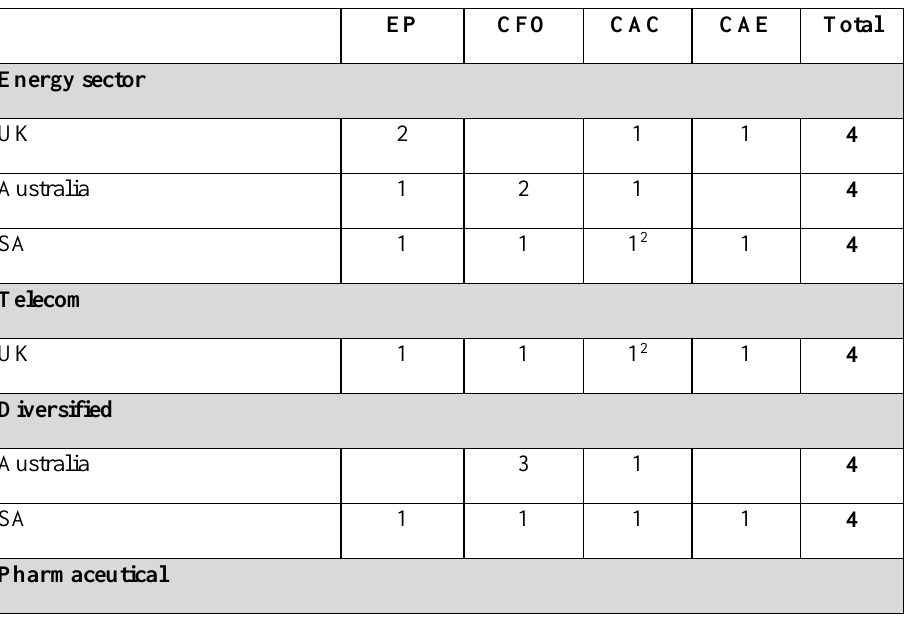
Table 2: Participants involved in the audit process classified by